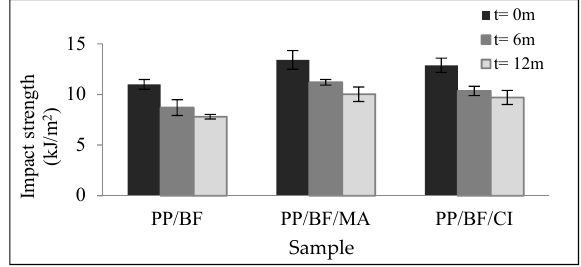
Figure 3 . Impact strength of composites before and after natural aging